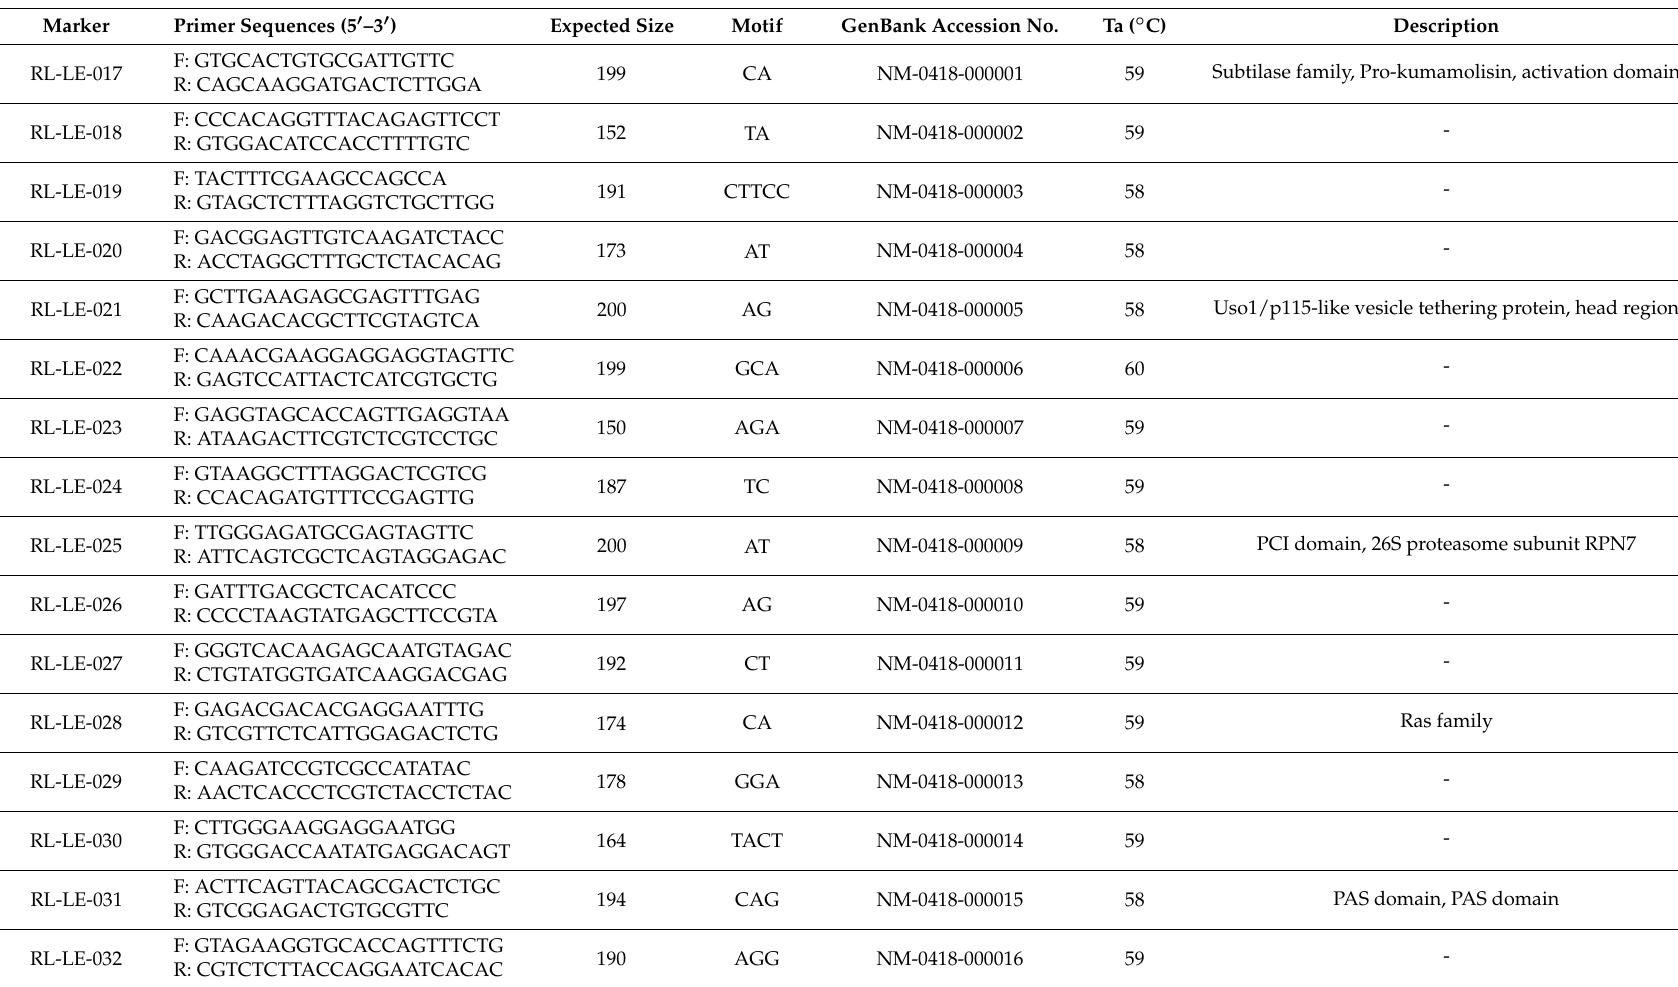
Table 2. Characteristics of the 44 simple sequence repeat (SSR) markers for shiitake mushroom ( Lentinula edodes ). Ta, annealing temperature.